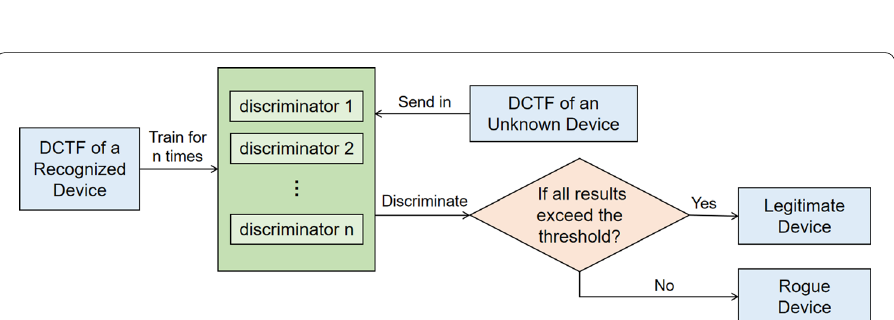
Fig. 15 The flowchart of the discrimination strategy when training for multiple time. This figure shows the flowchart of this improved discrimination